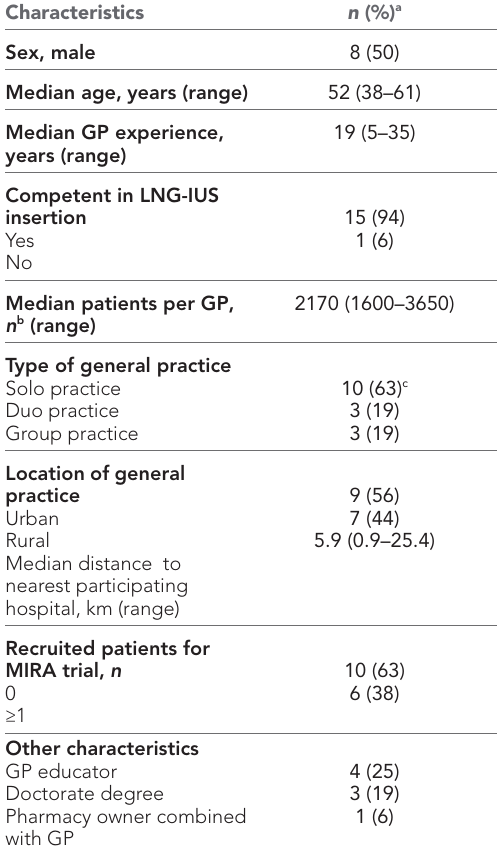
Table 1 Characteristics of participating GPs,